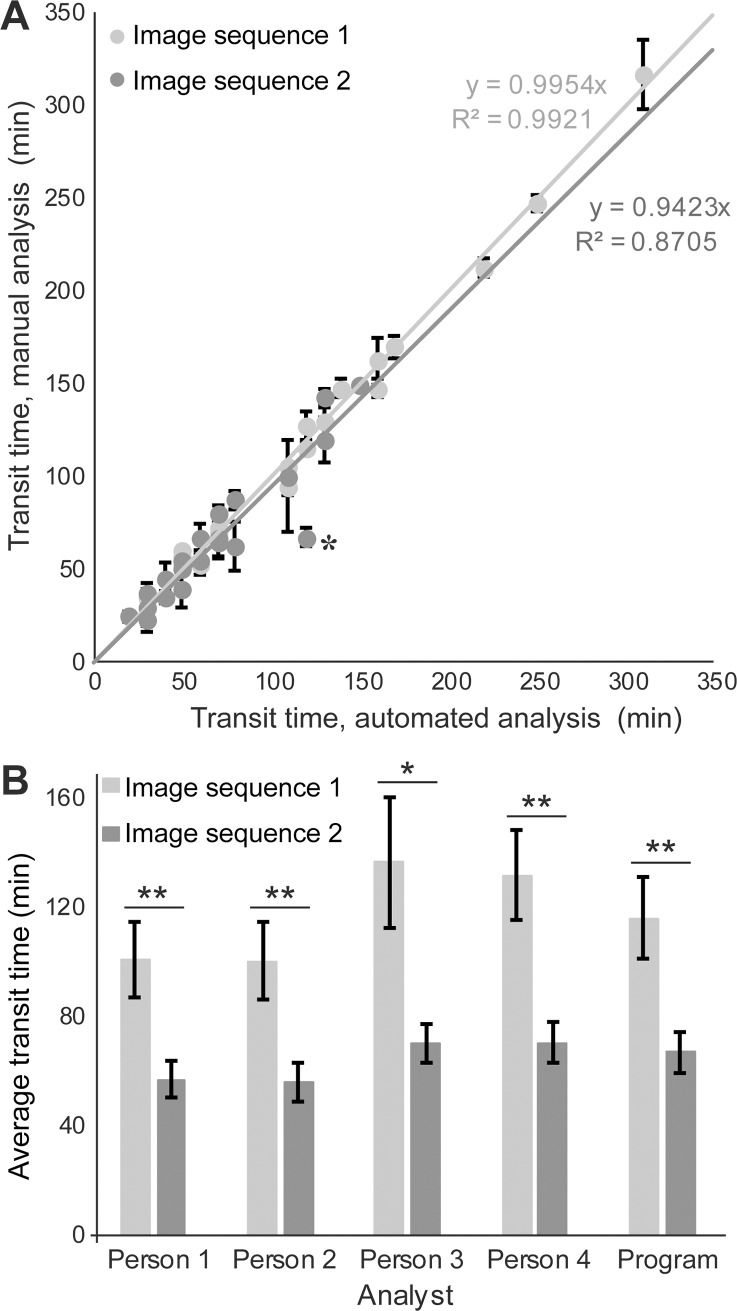
Verification of automated image analysis by comparison to manual analysis.(A) Automated analysis results plotted against manual analysis results (mean ± s.e.m. from four observers) for individual cells in two separate image sequences, each of which corresponds to a single section of a microfluidic device. For perfect agreement, the regression line plotted through these points would have a slope of one. Only one automated-analysis result substantially deviated from the manual reference, indicated by an asterisk. The manual analysis determined the nucleus to make two attempts to pass through the constriction, failing the first but succeeding the second time. The program identified this as a single, longer attempt. (B) Constriction transit times (mean ± s.e.m.) determined by four manual analysts and the automated analysis for the cells in the same two image sequences analyzed for panel A. Cells are BT-549 breast cancer and are either overexpressing lamin A (Image sequence 1) or an empty vector (Image sequence 2). Overexpression of lamin A results in less deformable nuclei and longer transit times through narrow constrictions (*, p < 0.05; **, p < 0.001 as calculated by ANOVA followed by Tukey’s multiple comparison test; n = 23–26 and 20–24 (depending on the analyst), respectively).